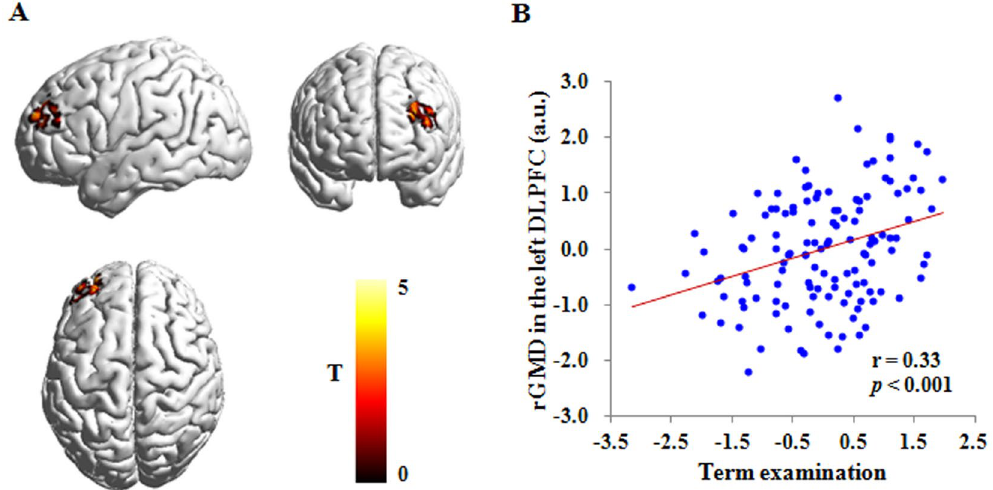
Figure 2. Brain regions that are related to term examination. ( A ) Brain images showing the positive association between the rGMD of the left DLPFC and term examination. ( B ) Scatter plot depicting the correlation between term examination and the rGMD of the left DLPFC (r = 0.33, p < 0.001). The score of horizontal axis represents the standardized residual of the term examination score (average standardized score of nine curriculum subjects) after adjusting for age, gender and total gray matter volume. The score of vertical axis represents the standardized residual of the rGMD in the left DLPFC after adjusting for age, gender and total gray matter volume. The color bar represents the Student’s T-test (T) scores in each voxel, 0 represents the minimum T score and 5 represents the maximum T score. rGMD = regional gray matter density; DLPFC = dorsolateral prefrontal cortex; a.u. = arbitrary